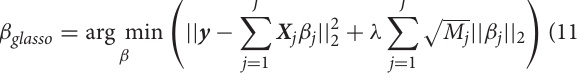
Algorithm 2 Affinity matrix